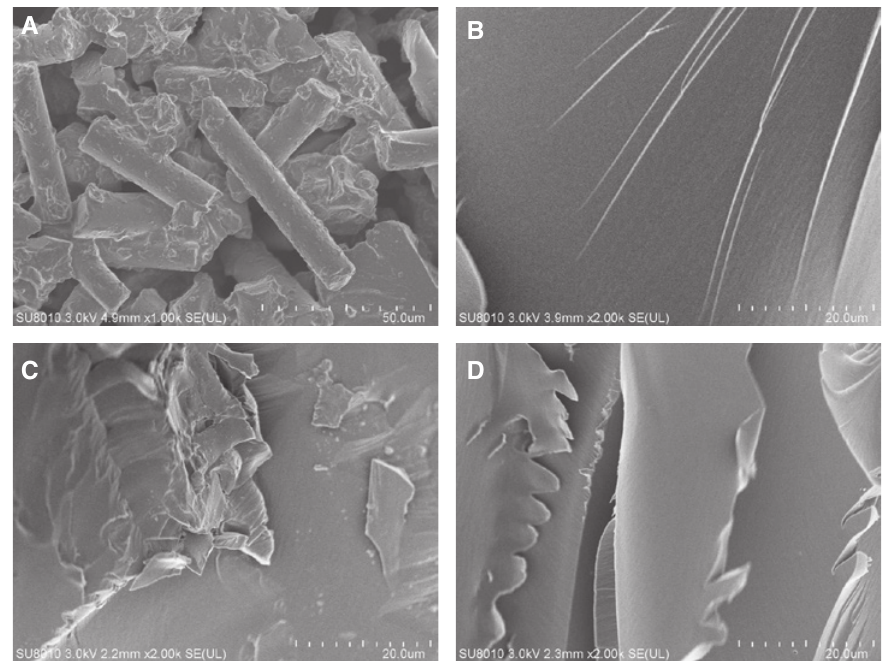
Figure 5: FESEM morphologies of the unmodified epoxy thermoset (A), GFs-HBPE (B) and epoxy composites with 1 wt GF-HBPE